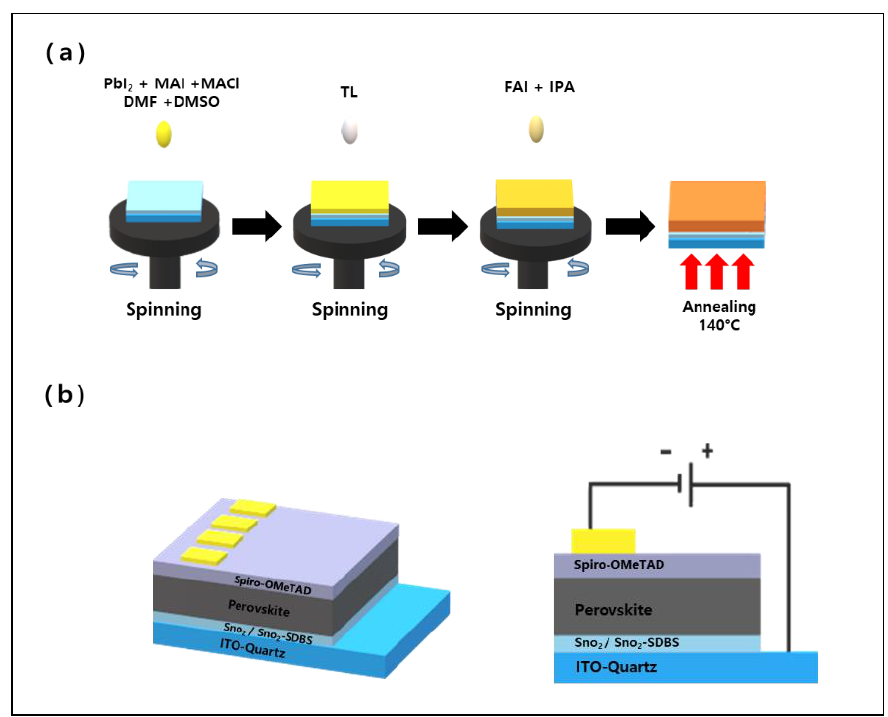
Figure 1. ( a ) Manufacturing process of mixed-cation perovskite FA x MA 1 − x PbI 3 ; ( b ) Schematic diagram of the device architecture on an ITO substrate.